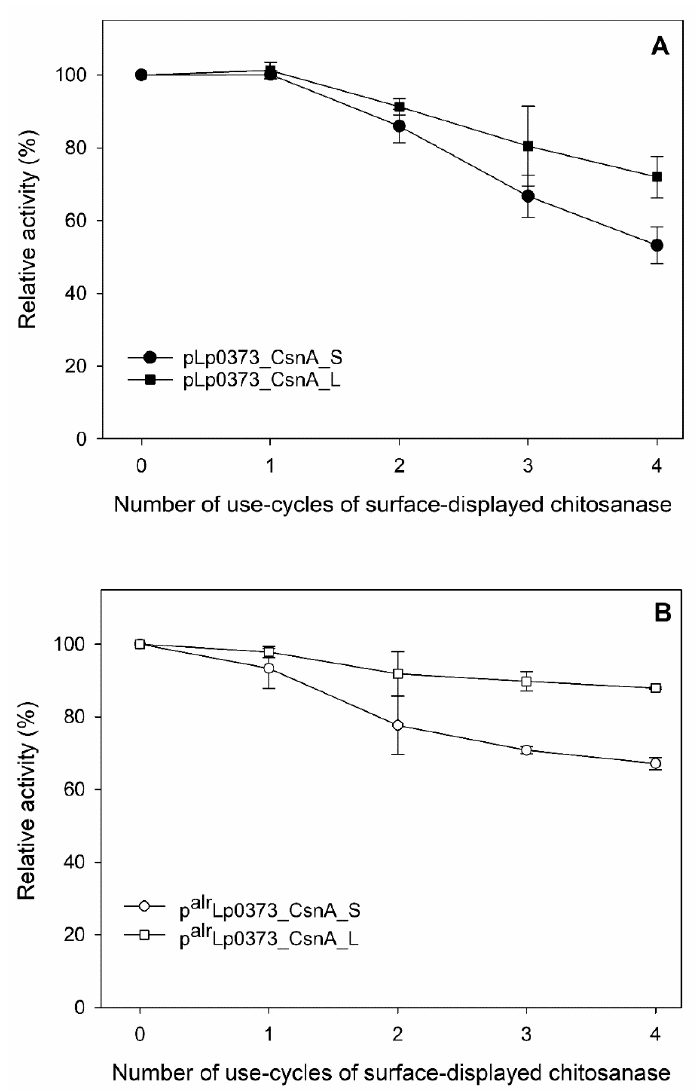
Figure 5. Enzymatic activity of CsnA displaying cells of repeated activity measurements. 0 indicates the first measurement after harvesting, while 1, 2, 3, 4 indicate the number of replications. ( A ) L. plantarum cells harbouring the erm -based expression plasmids ( B ) L. plantarum cells harbouring the alr -based expression plasmids. Experiments were performed in triplicates, and the standard deviation was always less than 5%.